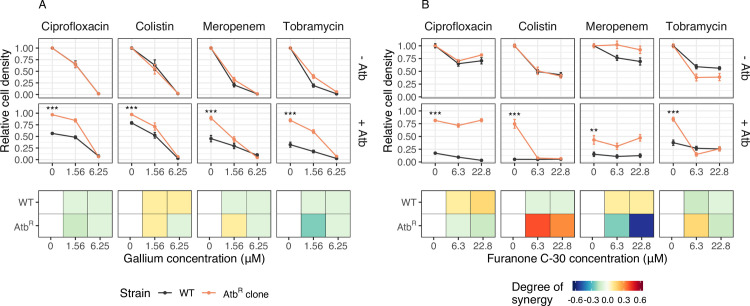
Effect of combination treatment on growth of AtbR clones.Test of whether the addition of gallium (A) or furanone (B) can restore growth suppression in AtbR clones (in orange) relative to the susceptible wild-type (WT; in black). Under antibiotic treatment and in the absence of antivirulence compounds, all AtbR clones grew significantly better than the WT (two-sample t tests, −26.63 ≤ t21–40 ≤ −3.03, p < 0.01 for all treatment combinations; n.s. = nonsignificant; *p < 0.05; **p < 0.01; ***p < 0.001), a result that holds for both scaled (as shown above) and absolute growth. In the presence of antivirulence compounds (upper series of panels without antibiotics [−Atb]; lower series of panels with antibiotics [+Atb]), growth suppression was restored in six out of eight cases. The exceptions were the ciprofloxacin-furanone and meropenem-furanone combinations. The bottom series of panels shows the degree of drug synergy for the WT and the AtbR clones. All cell density values (measured with flow cytometry as number of events detected in 5 μL of culture, after 24 hours) are scaled relative to the untreated control. All data are shown as means ± standard errors across a minimum of 16 replicates from 4 to 6 independent experiments. The underlying data for this figure can be found at https://doi.org/10.6084/m9.figshare.12515364. AtbR clones, antibotic resistant clones.